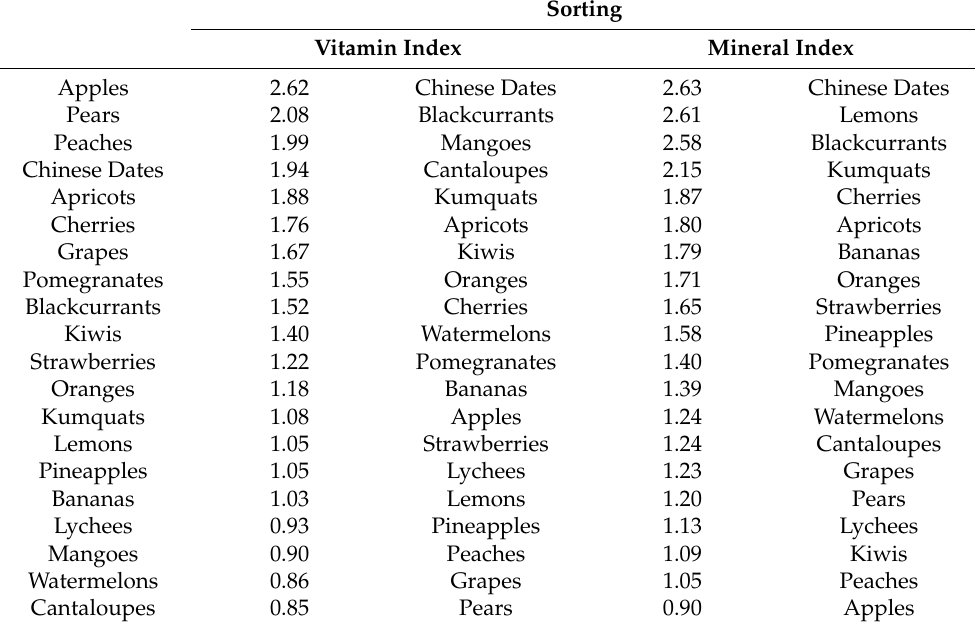
Table 3. The Vitamin Index and Mineral Index results in the